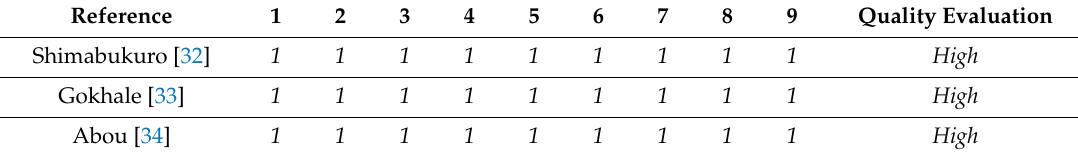
Table 4. The results of the critical appraisal assessments for randomized controlled trials (RCTs).